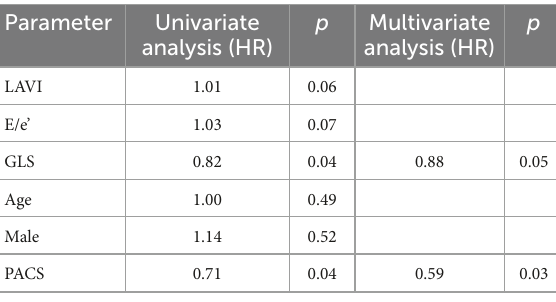
TABLE 2 Univariate and multivariate analysis for the prediction of cardiovascular death.